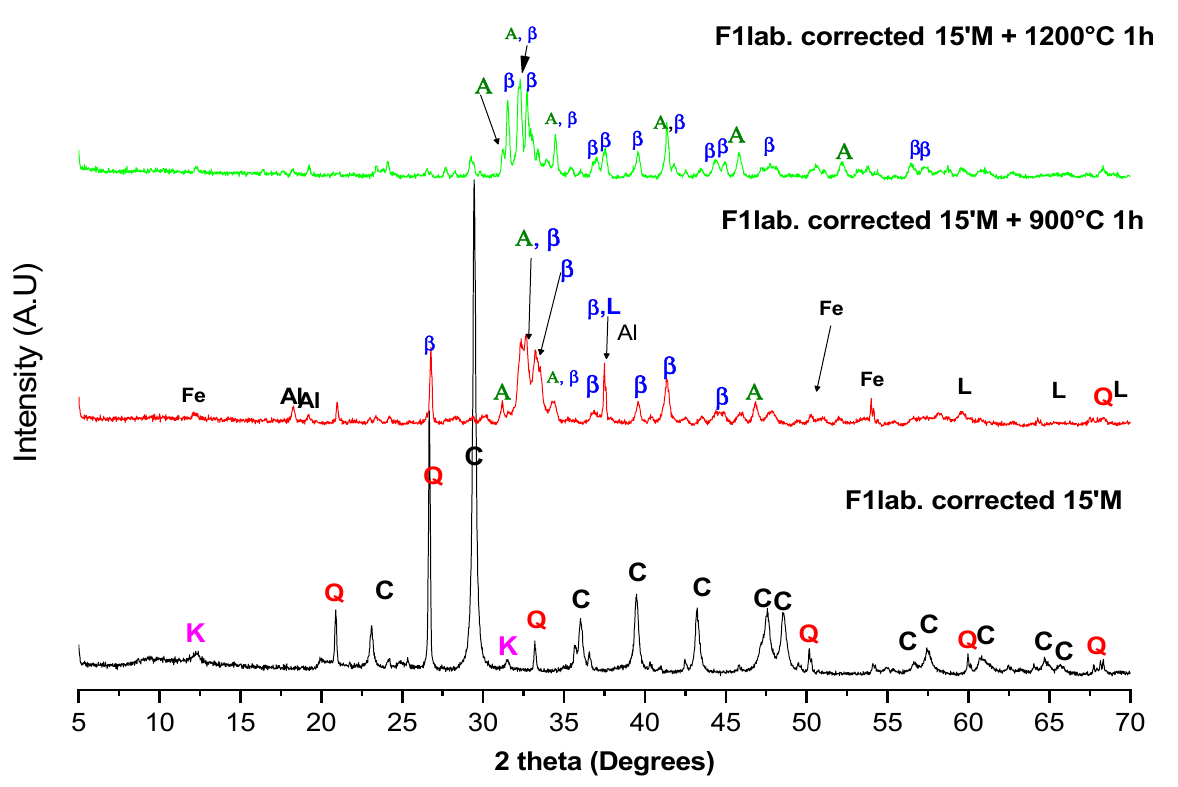
Figure 4. Diffraction patterns of the milled premix F1lab.corrected, and the clinker produced by indirect mechanosynthesis. Table 4. Phases quantifications (TOPAS) of the clinkers